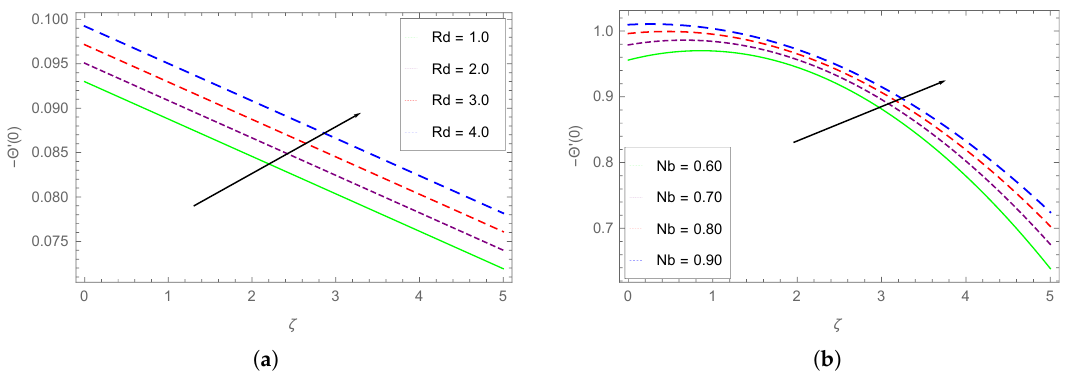
Figure 19. Dependence of Nusselt number on ( a ) Rd and ( b ) Nb